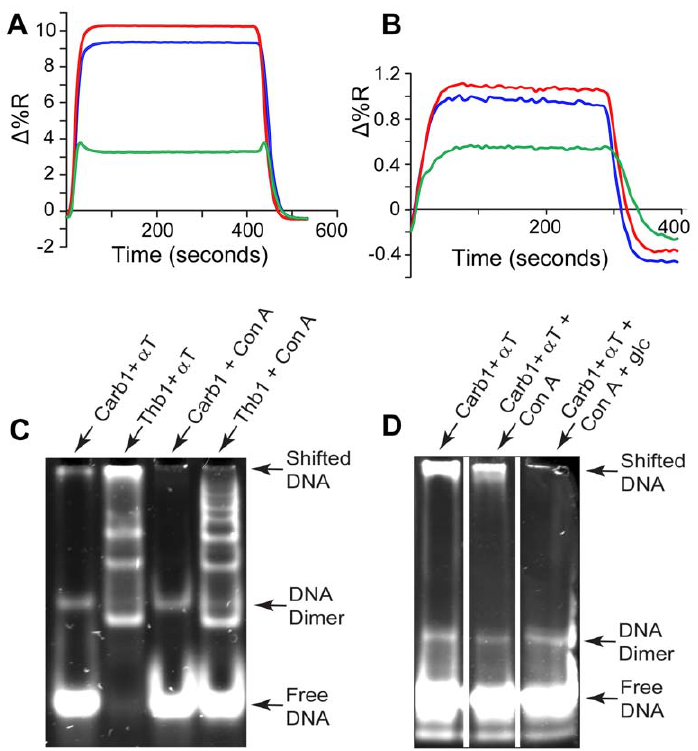
Figure 4. Motif II sequences bind carbohydrate moieties. SPR analysis of (Carb1, red), Thb1 (blue) and an A 15 control (green) with A , a -methyl- mannoside (AMM) and B , glucose (glc; note the expanded vertical scale). C , D , Electrophoretic mobility shift analysis: The affinity of Carb1 for a - thrombin ( a T) diminished on addition of Con-A, and disappeared on addition of glucose. DNA hairpins consistently had two bands in EMSAs, the upper (minor) band presumably due to a low concentration of dimerized hairpins.